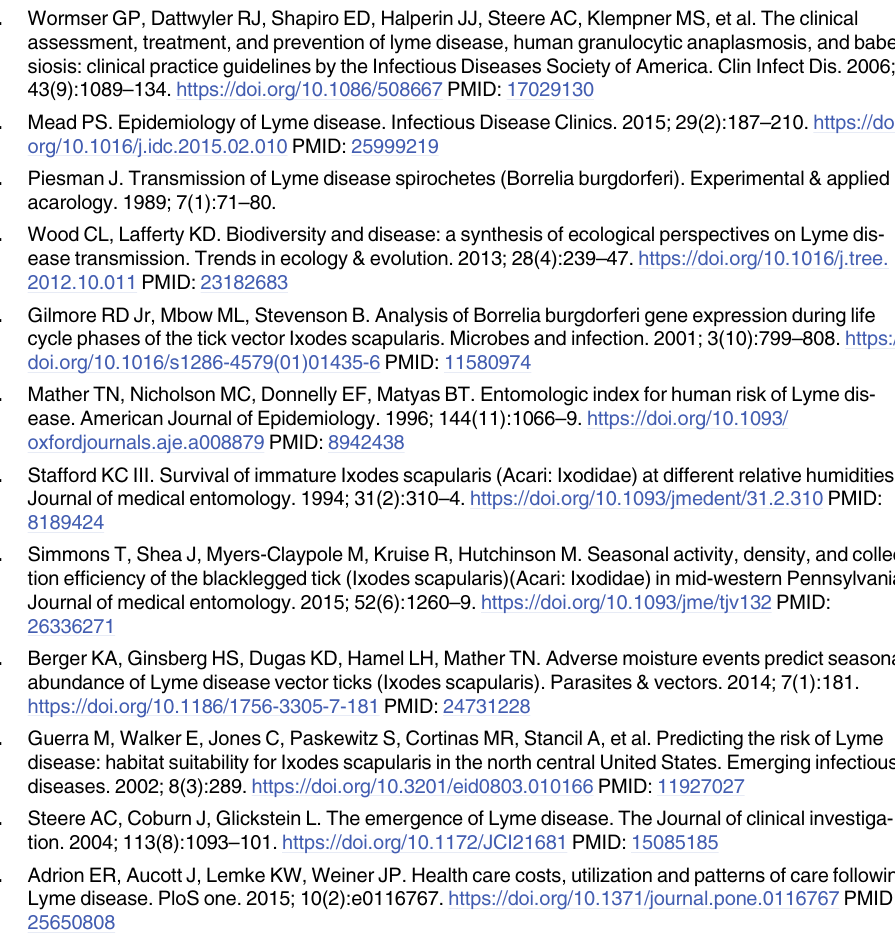
S4 Table. Predictions from full list models produce highly accurate predictions with low